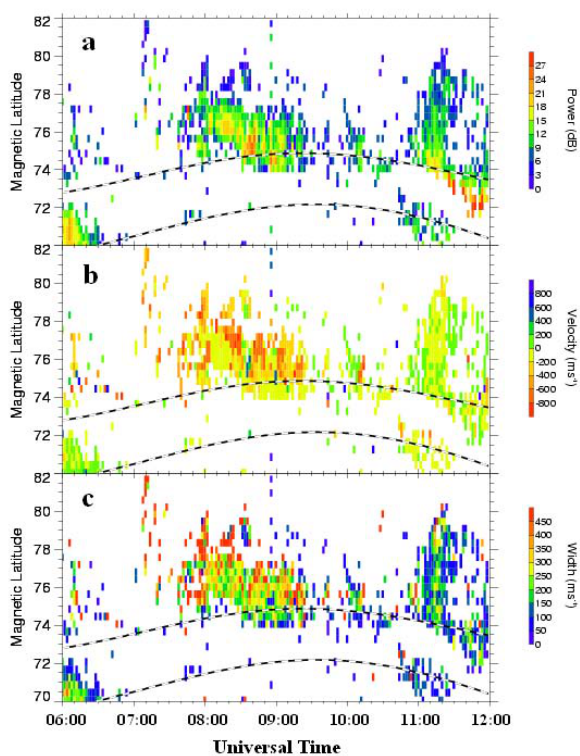
Fig. 8. (a) The echo power, (b) line-of-sight ion Doppler velocity, and (c) spectral width obtained from the Beam 9 observations dur- ing 06:00–12:00 UT (09:00–15:00 MLT at Longyearbyen) in the 70 ◦ –82 ◦ geomagnetic latitude range. The dashed lines denote the northward and southward edges of the Feldstein statistical auroral oval at Kp =4. The positive (negative) values of the ion Doppler velocity indicate the motions toward (away from) the radar site, namely, equatorward (poleward) flows.